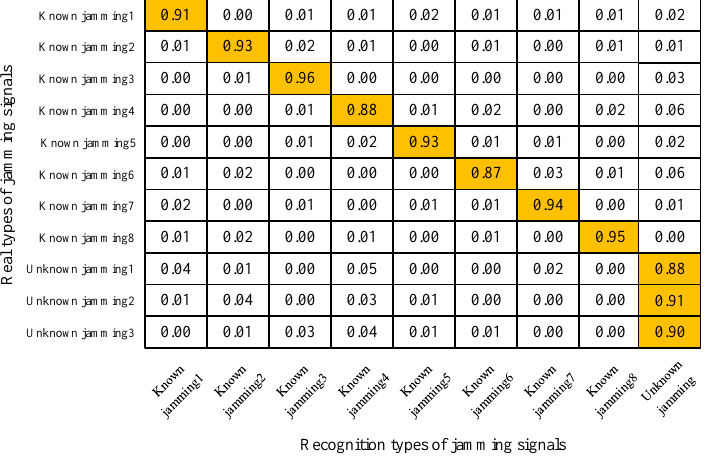
Figure 17. Recognition results of model based on OpenMax.